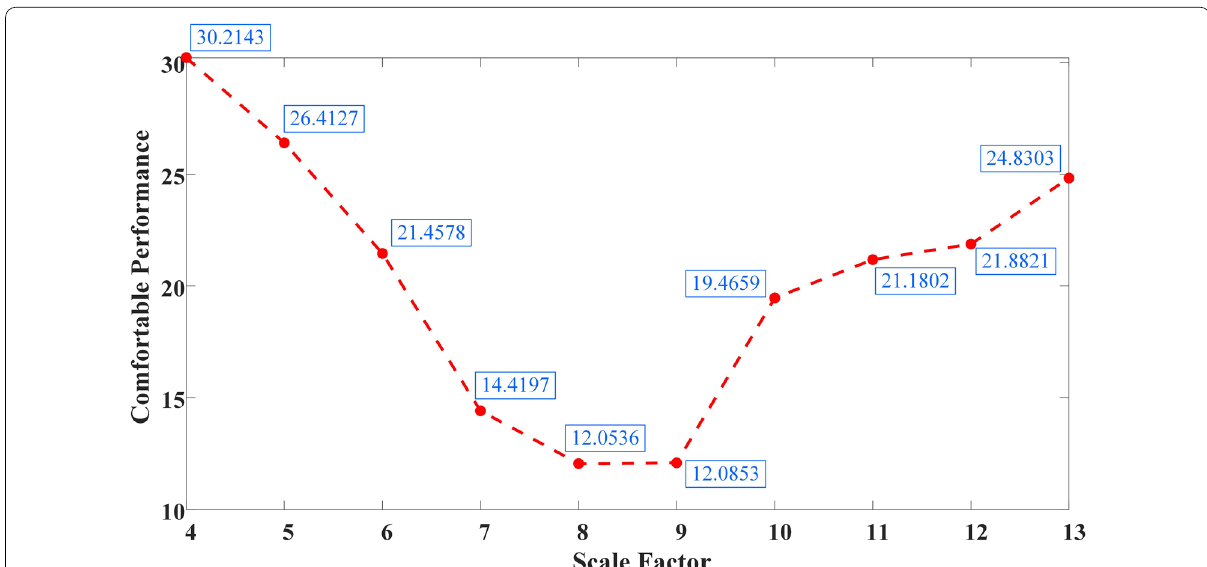
Figure 13 The wearable comfortable performance by using the constant admittance controller in different step frequency experiments